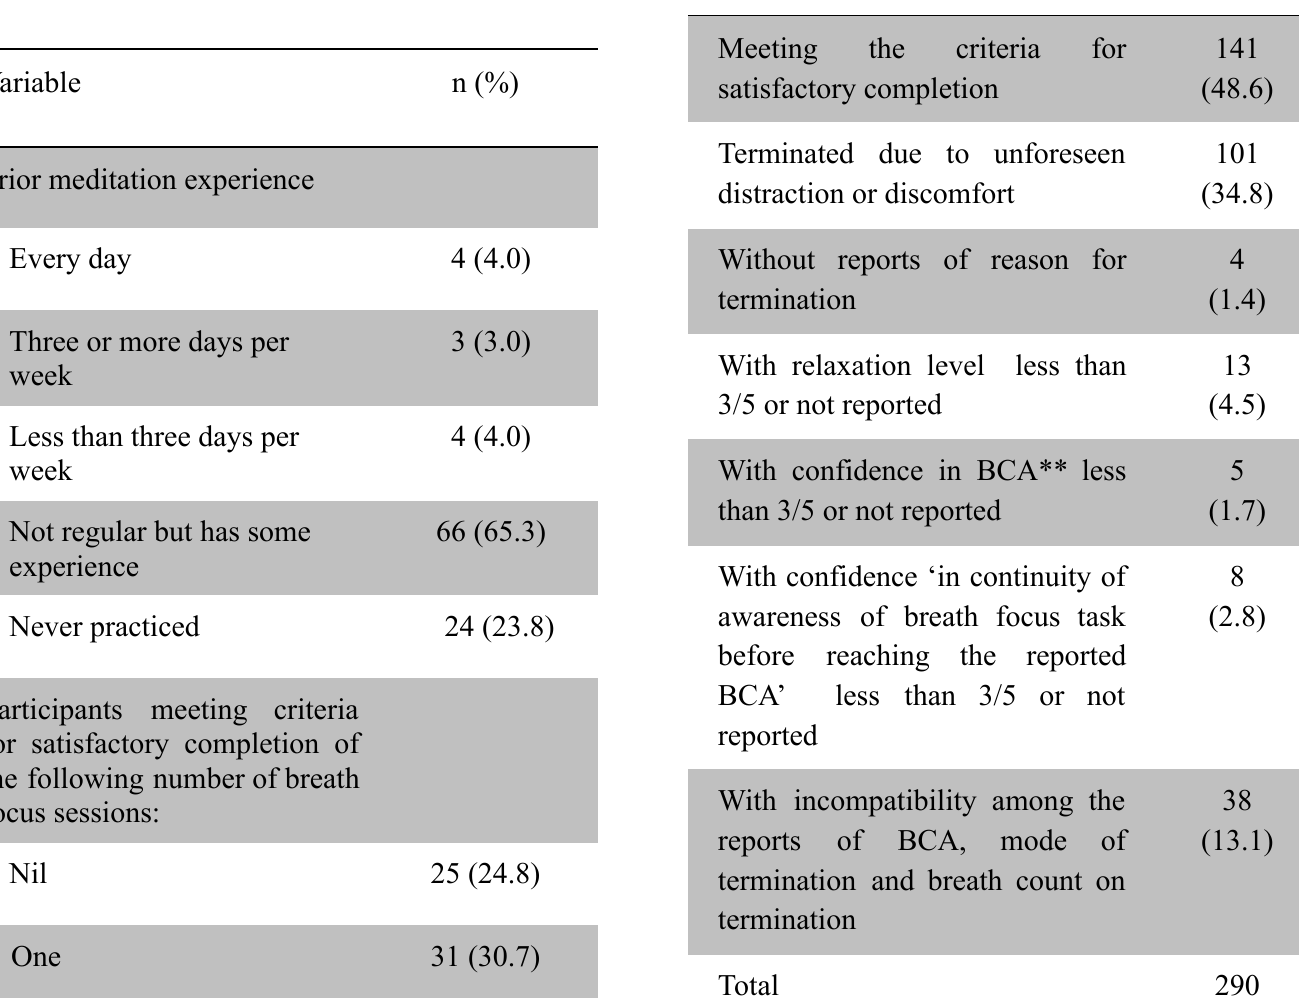
Table 2: Frequency distribution of breath